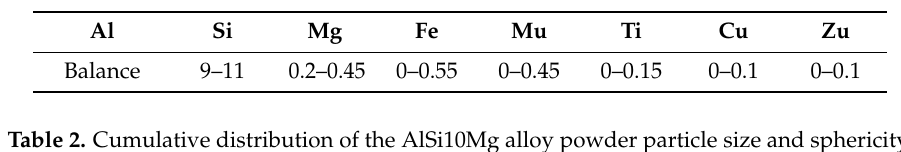
Table 1. Chemical composition, in wt.%, of AlSi10Mg alloy [27,28].